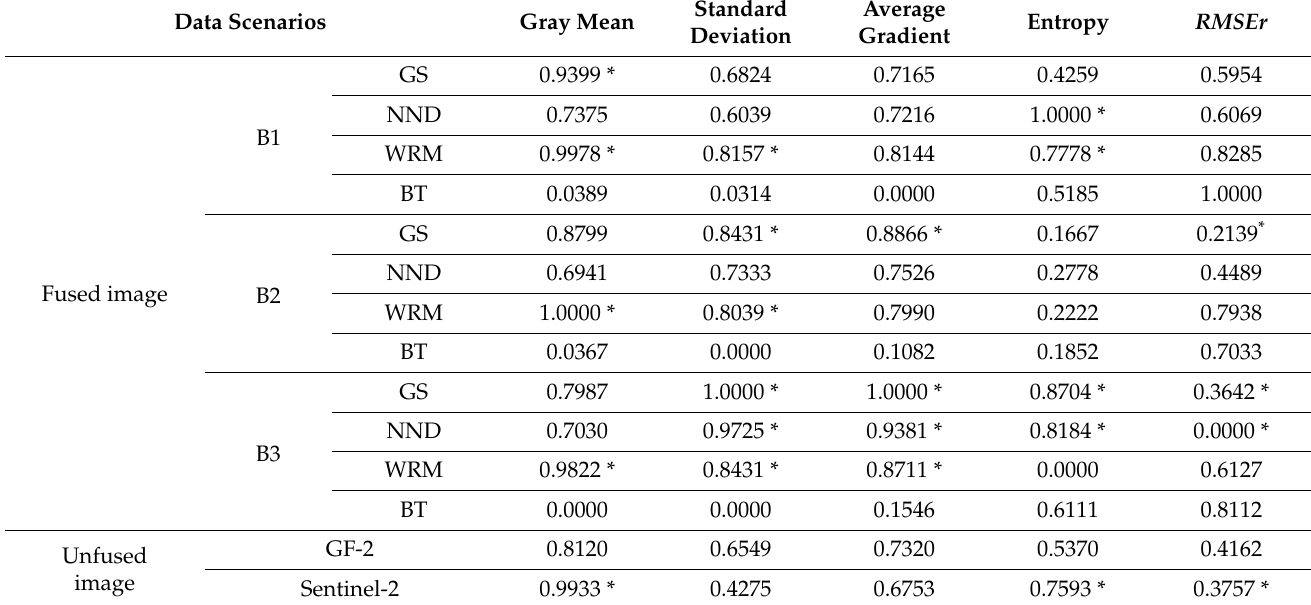
Table 5. Statistics of normalization for fusion image evaluation index. The RMSEr is calculated by the method in Section 3.3.2. The normalization formula is X’ = (X − min)/(max − min), where X’ is the normalized data, X is the original data, and max and min are the maximum and minimum values of the original dataset, respectively. The data marked with the symbol * indicates significant difference from other data at the 0.05 level, indicating that these marked images are superior to other unmarked images in corresponding evaluation indexes.